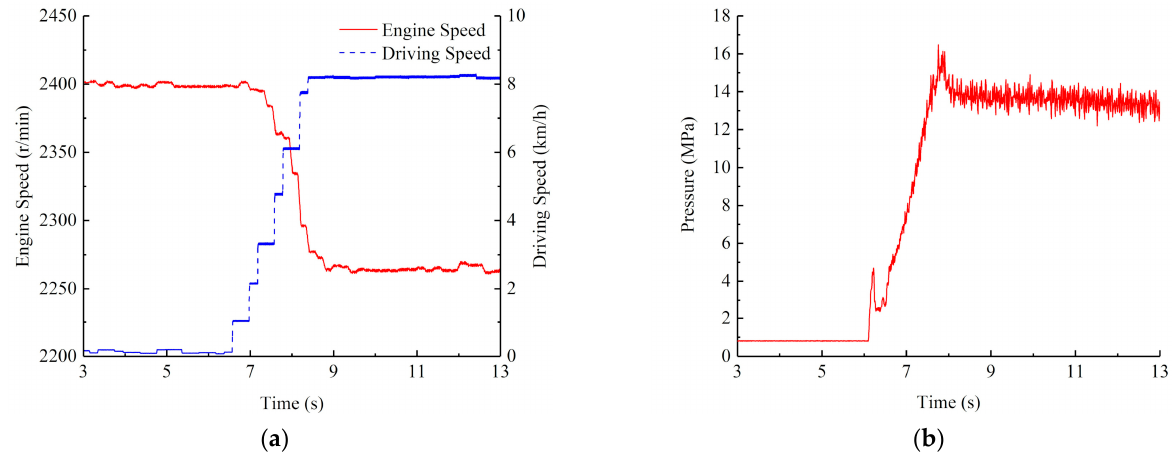
Figure 15. Parameters when starting on slope in Gear III: ( a ) change of the engine speed and driving speed; ( b ) change of the inlet and outlet pressure difference of the hydraulic motor.